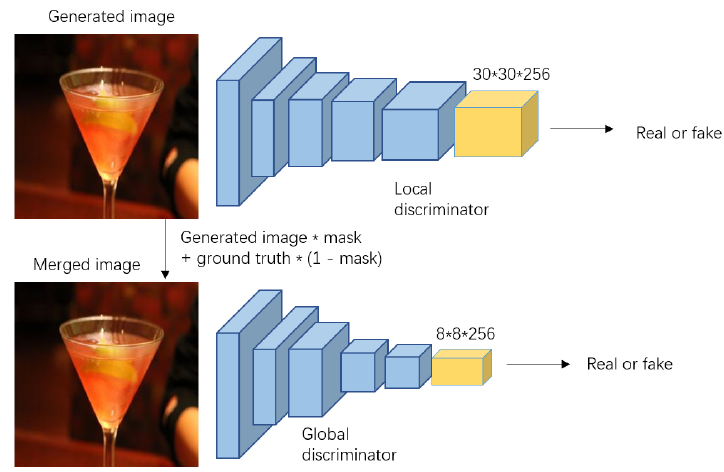
Figure 3. proposed GL-PatchGAN Discriminators framework.